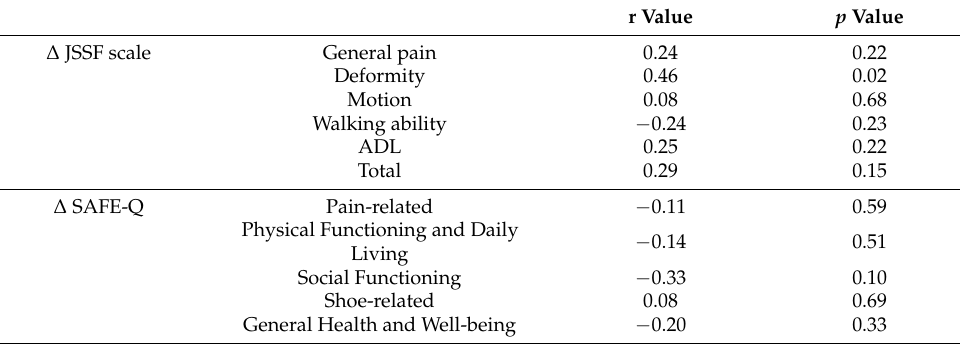
Table 3. Correlation between ∆ MOD and ∆ clinical